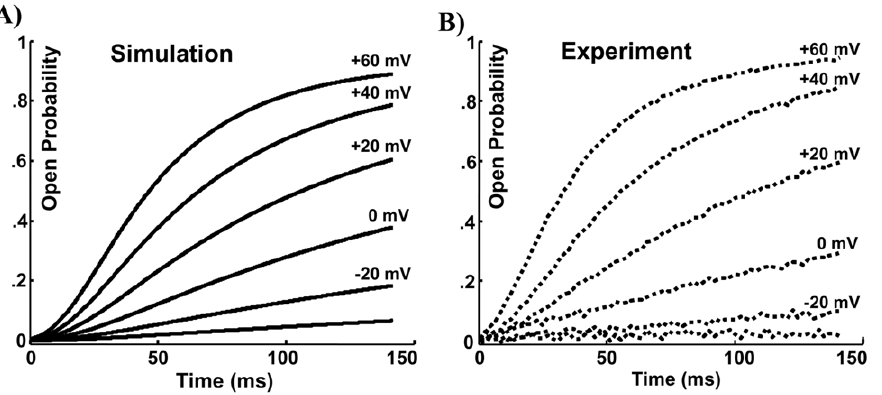
Figure 7. The first 150 ms of the open probability in a series of voltage clamp tests from rest potential of 2 100 mV to test potentials of 2 40, 2 20, 0, 20, 40 and 60 mV. Simulated currents (panel A) closely resemble measured currents (panel B), with slight amplitude difference.